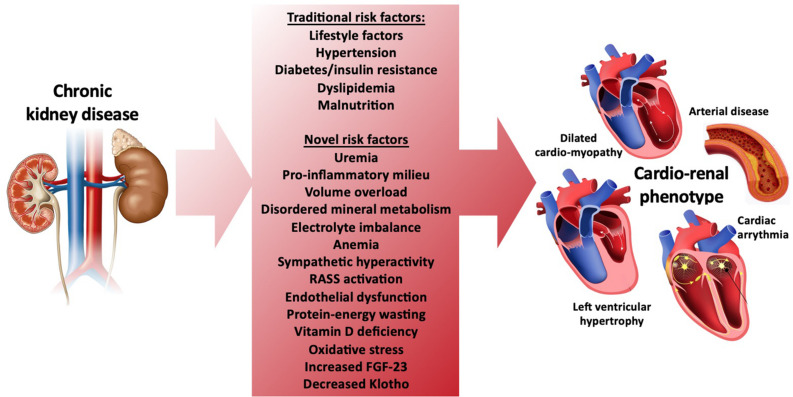
Traditional and novel risk factors for development of cardiovascular disease and the cardio-renal phenotype in CKD.